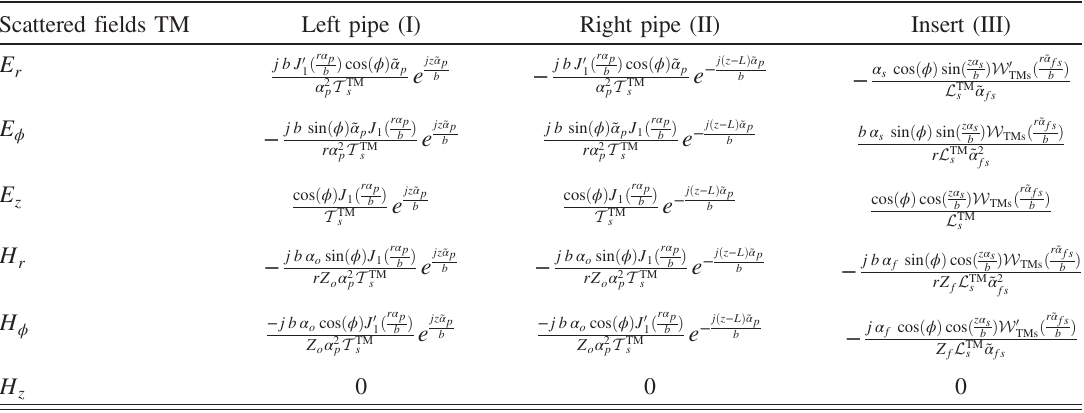
TABLE II. TM scattered field components (subdomains I – III). Scattered fields